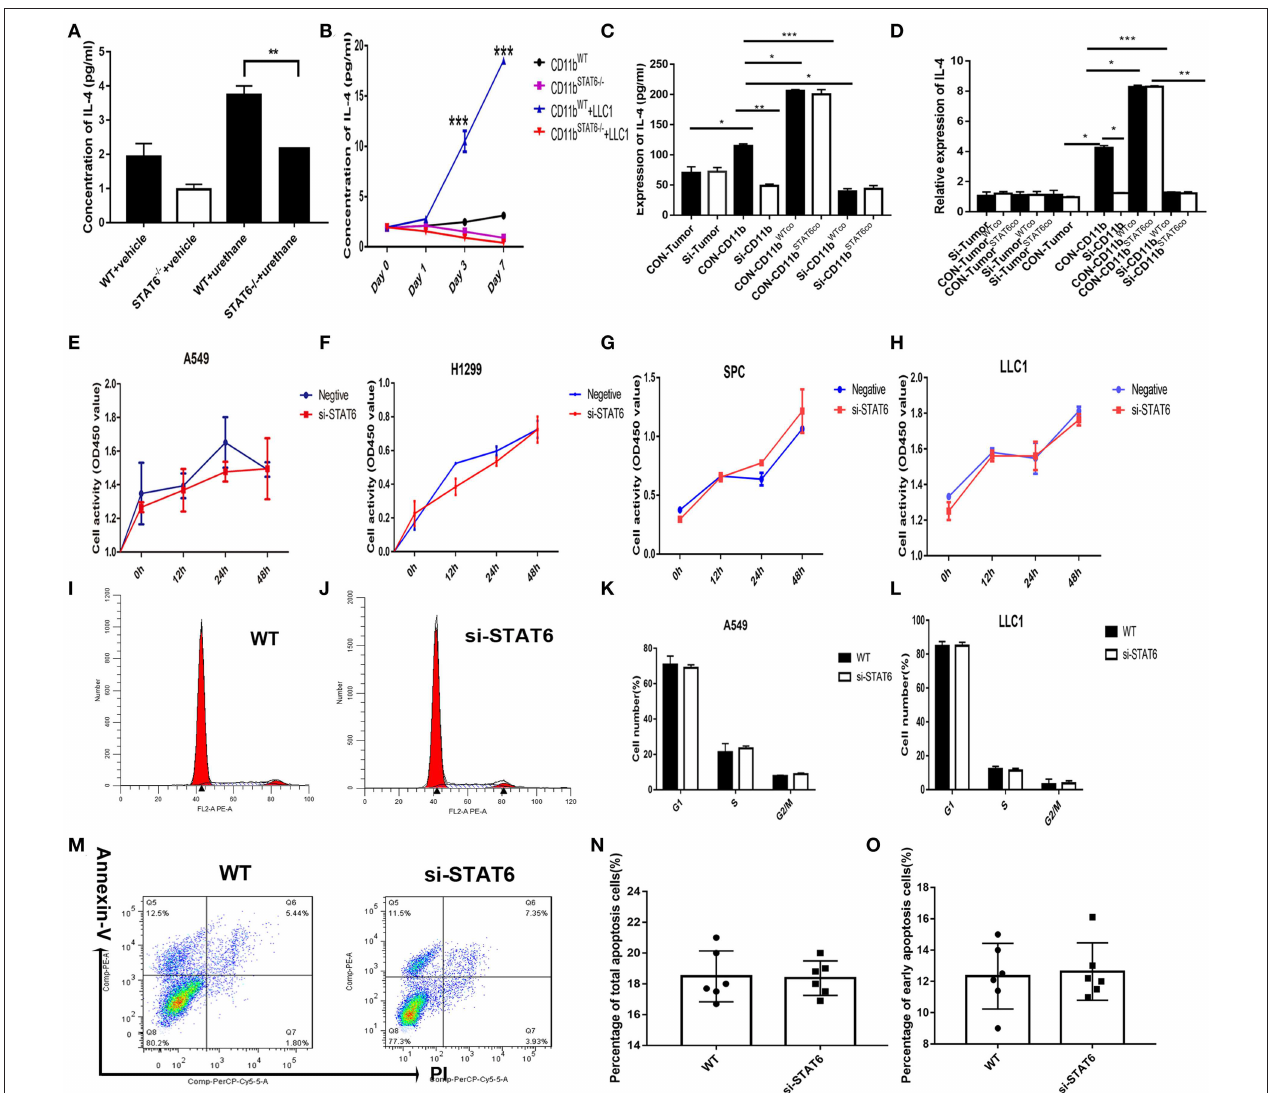
FIGURE 7 | Effect of signal transducer and activator of transcription 6 (STAT6) on IL-4 secretion in vitro. (A) Concentration of IL-4 (pg/ml) from bronchoalveolar lavage fluid in tumor-bearing wild-type (WT) and STAT6 − / − mice. (B) Concentration of IL-4 (pg/ml) in the serum when CD11b + cells were cocultured with lung cancer cells (LLC1) using Transwell plates. CD11b + cells were obtained for bone marrow of mice. (C) Secretion of IL-4 was measured by ELISA in the cocutured medium of tumor cells [STAT6 + / + or STAT6 − / − with CD11b + cells (STAT6 + / + or STAT6 − / − )]. CON-Tumor: LLC1 tumor cells. Si-Tumor: STAT6 knockdown in LLC1 cells. CON-CD11b: CD11b + cells. Si-CD11b: CD11b + cells from STAT6 − / − mice. CON-CD11b WTco : cocultured medium of LLC1 cells with STAT6 + / + CD11b + cells for analysis of IL-4 expression. CON-CD11b STAT6co : cocultured medium of LLC1 cells with STAT6 − / − CD11b + cells for analysis of IL-4 expression. Si-CD11b WTco : cocultured medium of STAT6 − / − LLC1 cells with STAT6 + / + CD11b + cells for analysis of IL-4 expression. Si-CD11b STAT6co : cocultured medium of STAT6 − / − LLC1 cells with STAT6 − / − CD11b + cells for analysis of IL-4 expression. (D) mRNA expression of IL-4 was analyzed using RT-PCR. CD11b + cells were isolated from STAT6 − / − mice and WT littermates. CON-CD11b: CD11b + cells from bone marrow of WT mice. Si-CD11b: CD11b + cells from STAT6 − / − mice. CON-Tumor: LLC1 tumor cells. Si-Tumor: STAT6 knockout in LLC1 cells. CON-Tumor WTco : LLC1 cells were separated after 48h of coculture with CD11b + cells. CON-Tumor STAT6co : LLC1 cells were separated after 48h of coculture with STAT6 − / − CD11b + cells for analysis of IL-4 expression. Si-Tumor WTco : STAT6 − / − LLC1 cells were separated after 48h cocultured with STAT6 + / + CD11b + cells for analysis. Si-Tumor STAT6co : STAT6 − / − LLC1 cells were separated after 48h of coculture with STAT6 − / − CD11b + cells for analysis. CON-CD11b WTco : STAT6 + / + CD11b + cells were separated after 48h of coculture with STAT6 + / + LLC1 cells. CON-CD11b STAT6co : STAT6 + / + CD11b + cells were separated after 48h of coculture with STAT6 − / − LLC1 cells. Si-CD11b WTco : STAT6 − / − CD11b + cells were separated after 48h of coculture with STAT6 + / + LLC1 cells. Si-CD11b STAT6co : STAT6 − / − CD11b + cells were separated after 48h of coculture with STAT6 − / − LLC1 cells for analysis of IL-4 expression. (E–H) CCK8 proliferation analysis of human lung cancer-derived cells (A549, H1299, SPC-A1) and mouse lung cancer-derived cells (LLC1) after genetic knockdown of STAT6. The knockdown efficiencies of si-STAT6 in A549, H1299, SPC-A1, and LLC1 were 85, 90, 97.5, and 88%, respectively, as verified by RT-PCR. (I,J) Representative results of cell cycle analysis in WT and si-STAT6 groups. (K,L) Comparative percentages of cells in G1, S, and G2/M between WT and STAT6 − / − groups in A549 and LLC1 cells. (M) Flow cytometry analysis of apoptosis. (N) Percentages of apoptotic cells in the WT and STAT6 − / − groups (annexin-V-positive, PI-positive or -negative). (O) Percentages of early apoptotic cells (annexin-V-positive, PI-negative). si-STAT6, STAT6 knockdown.